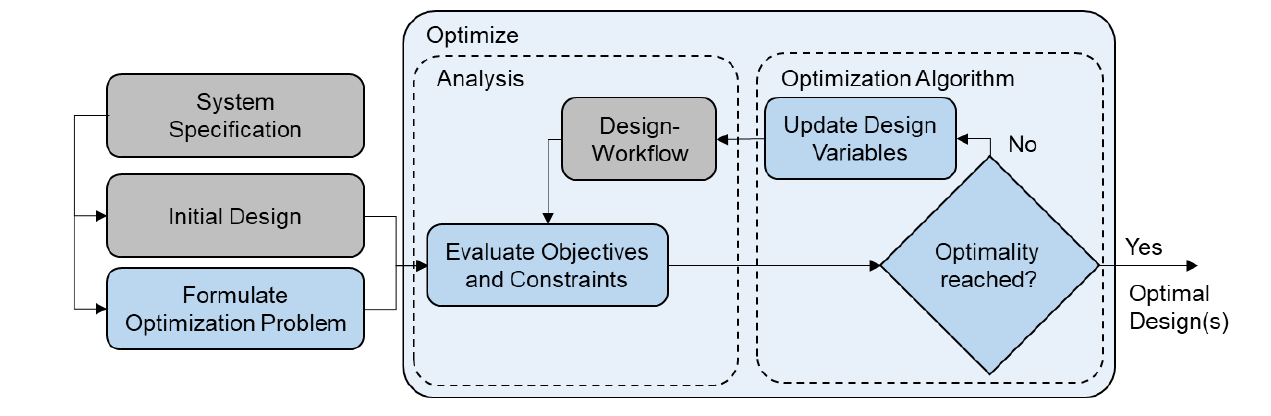
Figure 9. Optimization-based iteration.